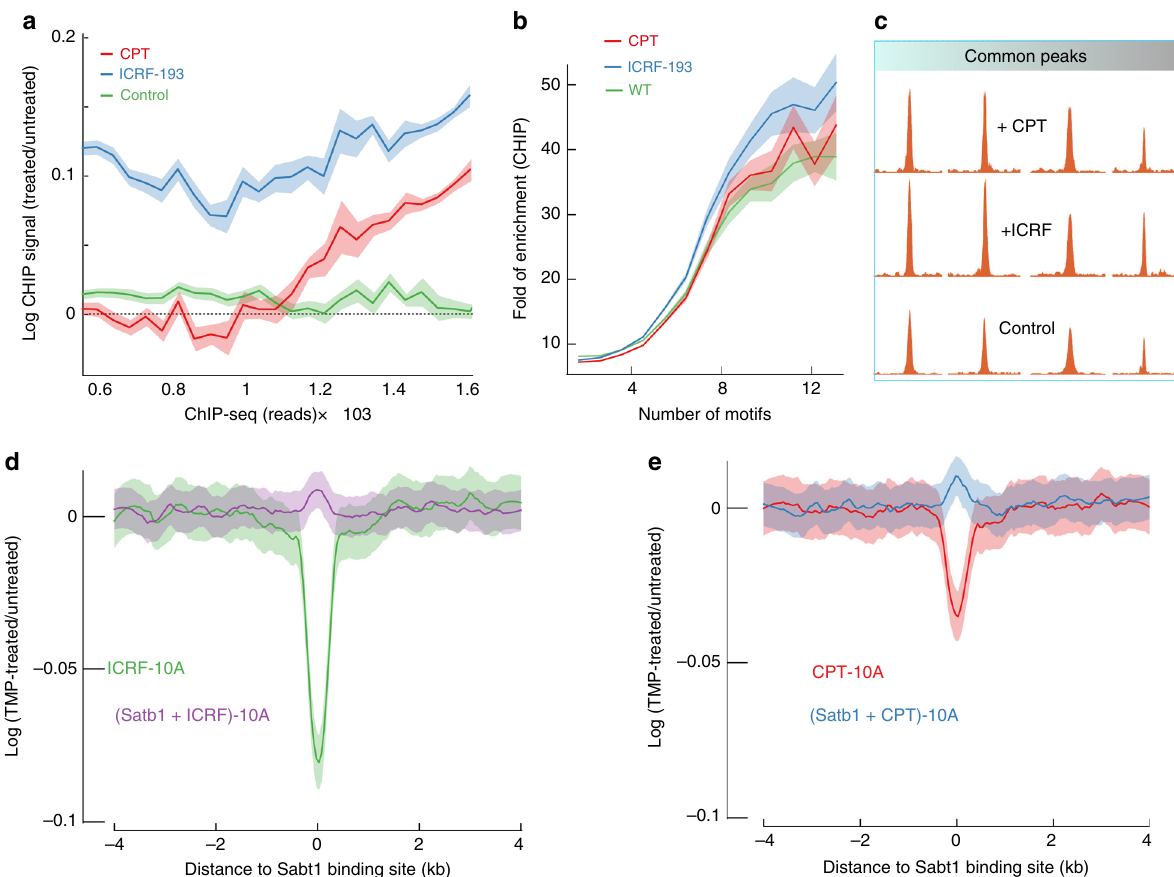
Fig. 4 Satb1 binds better under enhanced negative torsional stress and stabilizes BURs. a Satb1 ChIP-seq signal ratio of “ MCF-10A + Satb1 ” cells treated with Topo I or II inhibitors, ICRF-193 (blue) and CPT (red), respectively, over untreated “ MCF-10A + Satb1 ” cells, plotted against increasing raw ChIP-seq reads. The green line shows the ratio between two wild-type replicates. The logarithm plot of ratio shows increased Satb1 binding upon treatment. b Plot of ChIP-seq signal of ICRF-193 (blue), CPT (red) treated “ MCF-10A + Satb1 ” cells versus motif density calculated from a 400bp window centered on Satb1 binding sites. c Few representative examples of ChIP-seq peak intensity before treatment (lower panel) and after treatment with ICRF-193 (middle panel) and CPT (upper panel). d, e TMP-seq was performed on native MCF10A cells and cells expressing exogenous Satb1 in presence and absence of CPT and ICRF-193 respectively. Final TMP-seq signal was derived after correction for free genomic DNA-sequence bias at 50 bp resolution across a 4 kb window centered on Satb1 binding sites. Ratio of TMP-seq signals in “ MCF-10A + Satb1 ” cells treated with CPT ( d ) or ICRF-193 ( e ) over untreated “ MCF-10A + Satb1 ” cells. All error envelopes represent standard error of mean. Source data are provided as a Source Data fi